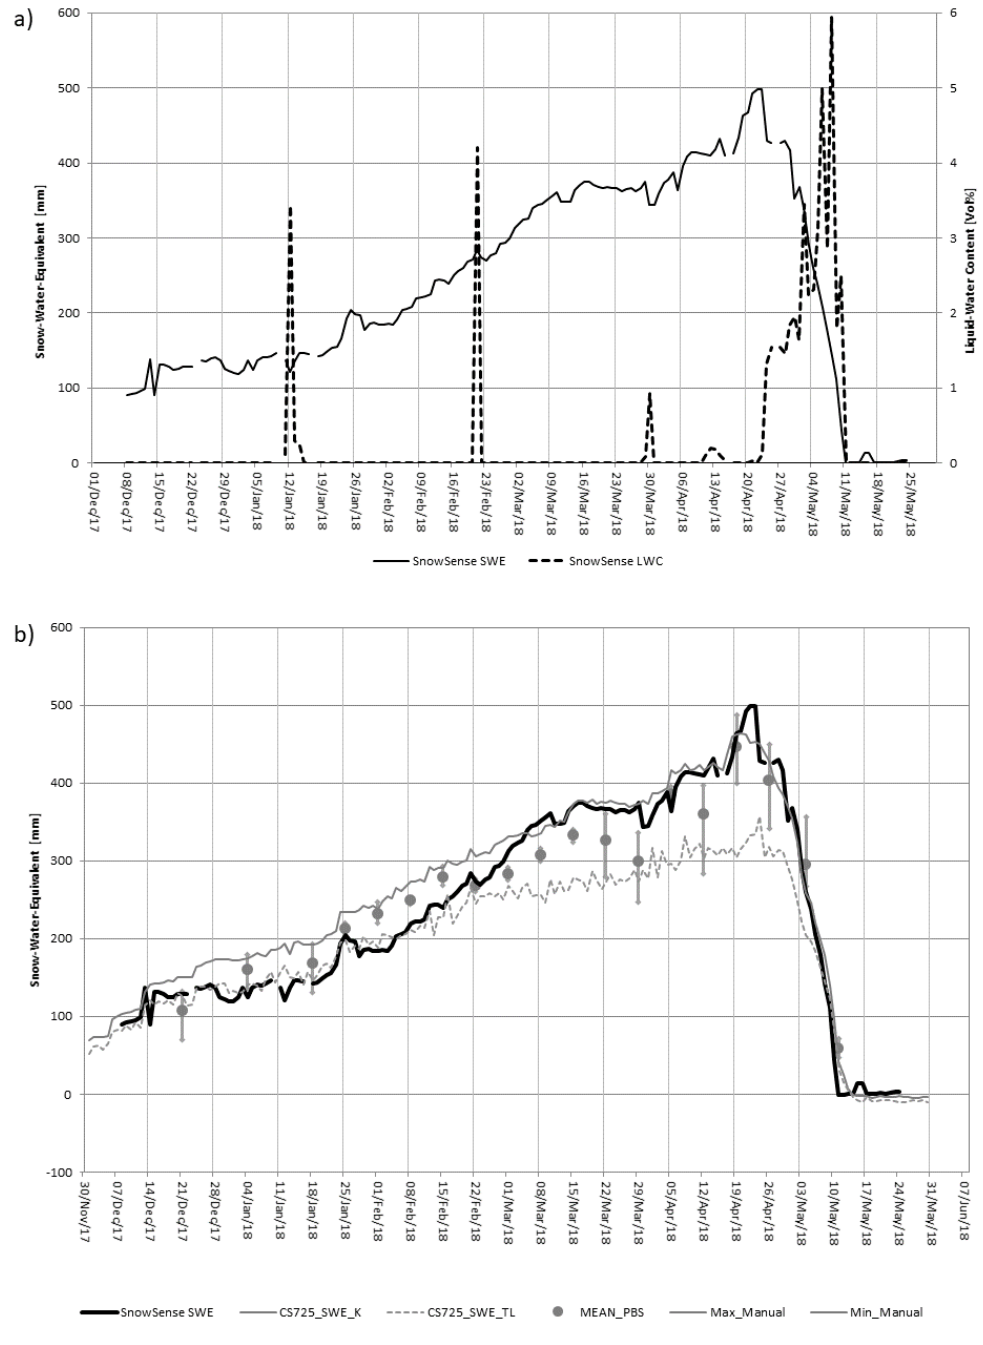
Figure 5. ( a ) daily GNSS-derived SWE and LWC values at the Forêt Montmorency NEIGE site 2017/2018; ( b ) daily GNSS-derived SWE values and reference measurements from two GMON CS725 sensors and manual snow pit measurements of mean, minima and maxima SWE at the Forêt Montmorency NEIGE